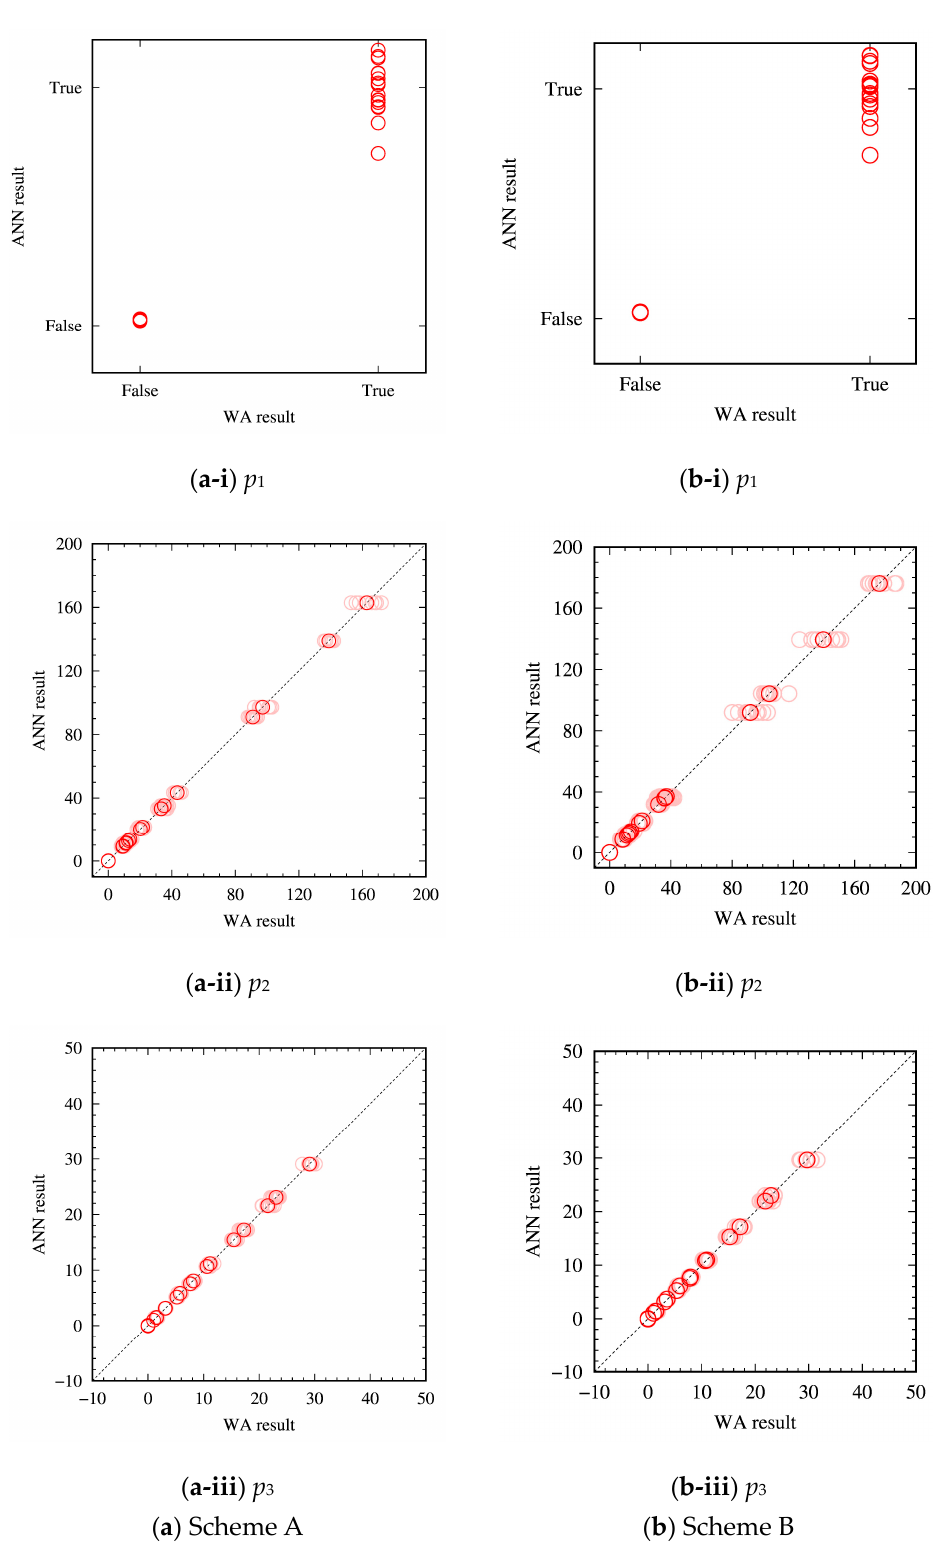
Figure 4. Comparison of predicted dislocation structures with the ANN and WA solutions for the training parameter sets of ( a ) Scheme A and ( b ) Scheme B. (i), (ii) and (iii) show Boolean values representing whether a dislocation wall structure is formed, p 1 , the number of walls, p 2 , and the average width of the formed walls, p 3 , respectively. In (ii) and (iii), the red and faded red plots show the results after and before averaging with the same initial structure, respectively.